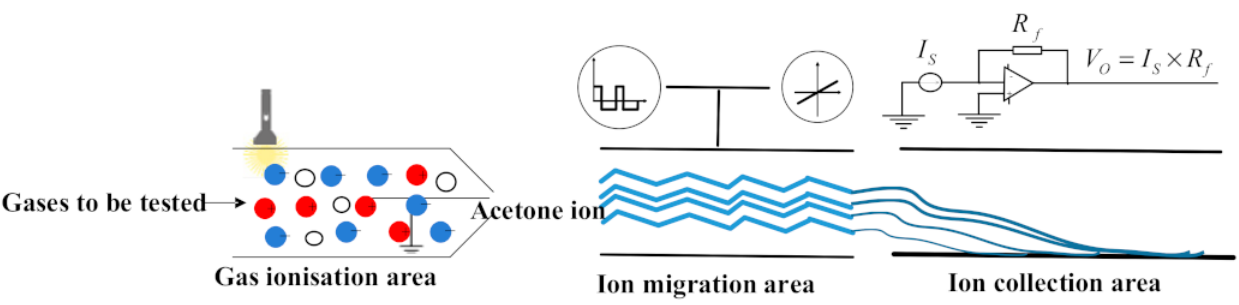
Figure 1. The structure of the FAIMS gas